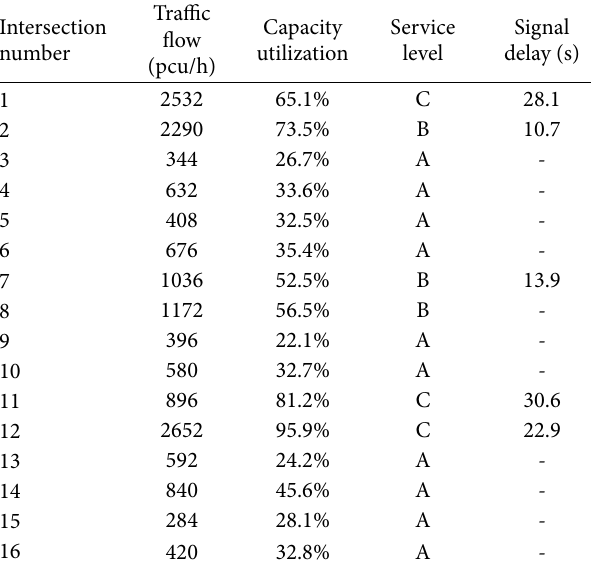
Table 3: Traffic conditions of intersections simulated in Synchro.